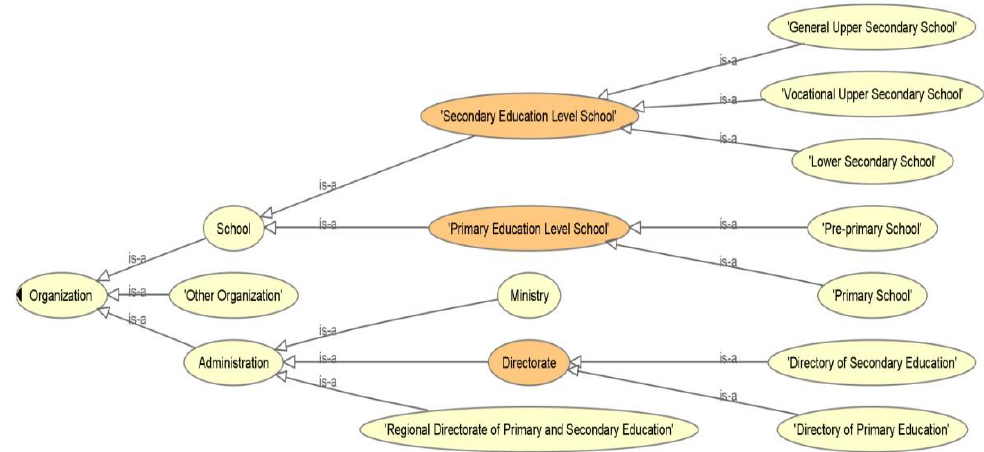
Figure 1. The Organization class hierarchy as shown in Protégé.